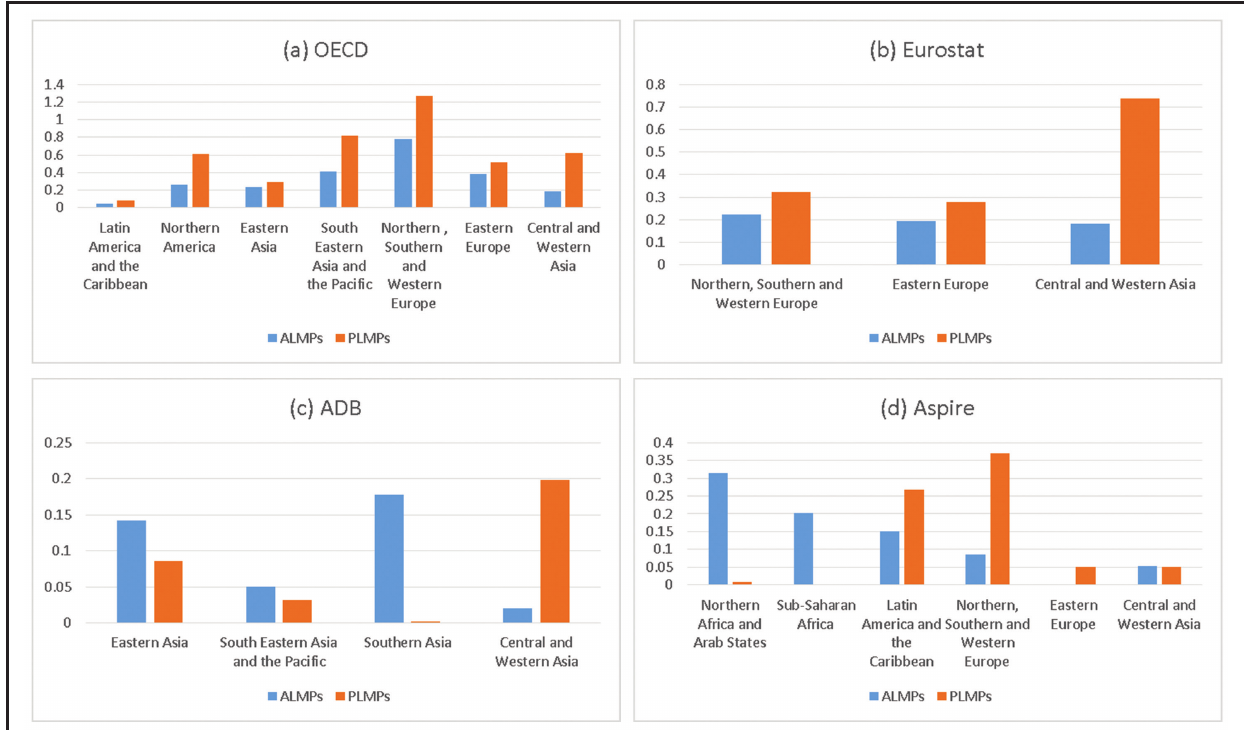
Figure 1. Average spending in ALMPs and PLMPs across regions as a share of